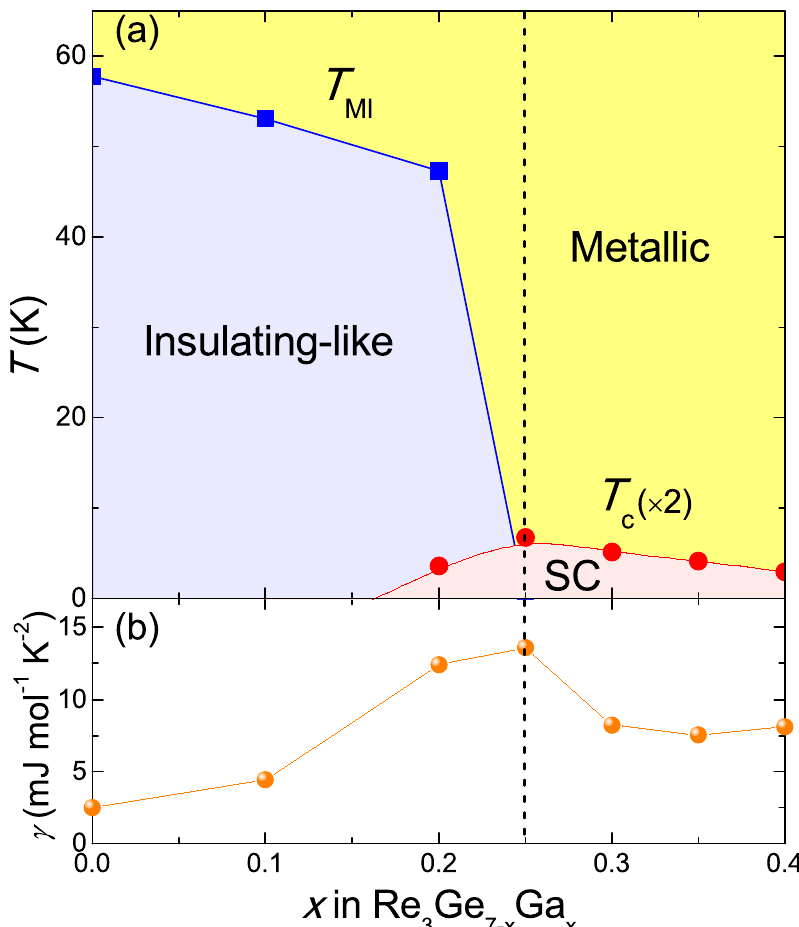
Fig. 5 Electronic phase diagram of Re 3 Ge 7 − x Ga x and its comparison with the variation of electronic speci fi c heat. a T - x electronic phase diagram of Re 3 Ge 7 − x Ga x . Note that the T c data are multiplied by a factor of 2 for clarity. b x dependence of electronic speci fi c-heat coef fi cient, respectively. The vertical dashed line is a guide to the